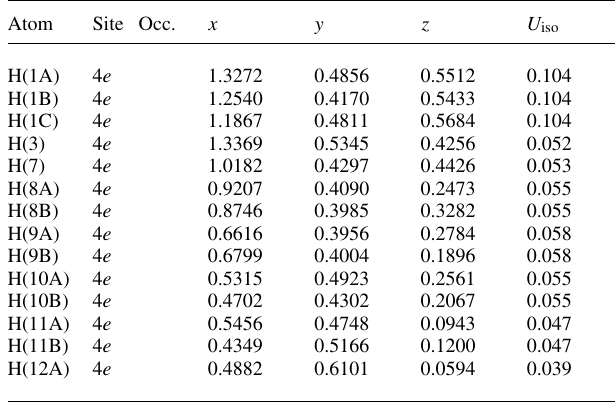
Table 2. Atomic coordinates and displacement parameters (in Å 2 )